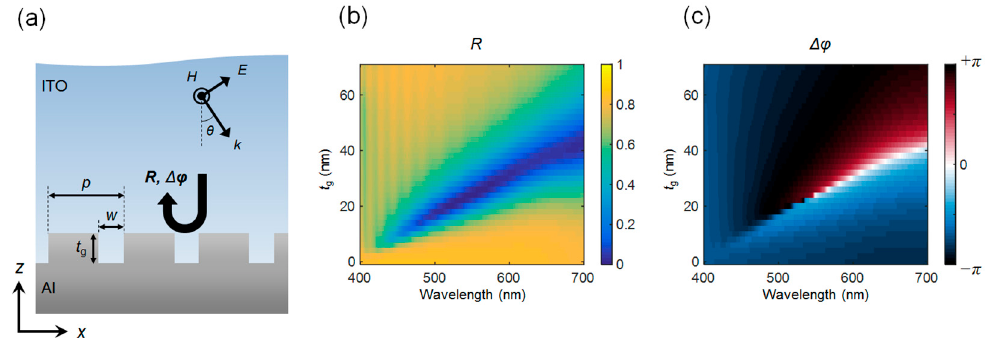
Figure 2. ( a ) Calculation geometry for determining reflection and phase shift characteristics in the subwavelength Al grating covered with ITO. ( b ) Spectral reflectance and ( c ) phase shift of the metallic grating for normally illuminated visible light ( θ = 0) with respect to grating thicknesses ranging from 0 to 70 nm.